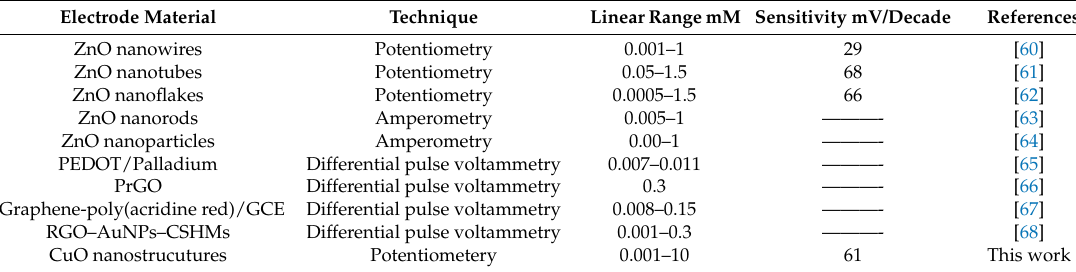
Table 4. The comparison of presented uric acid biosensor with existing